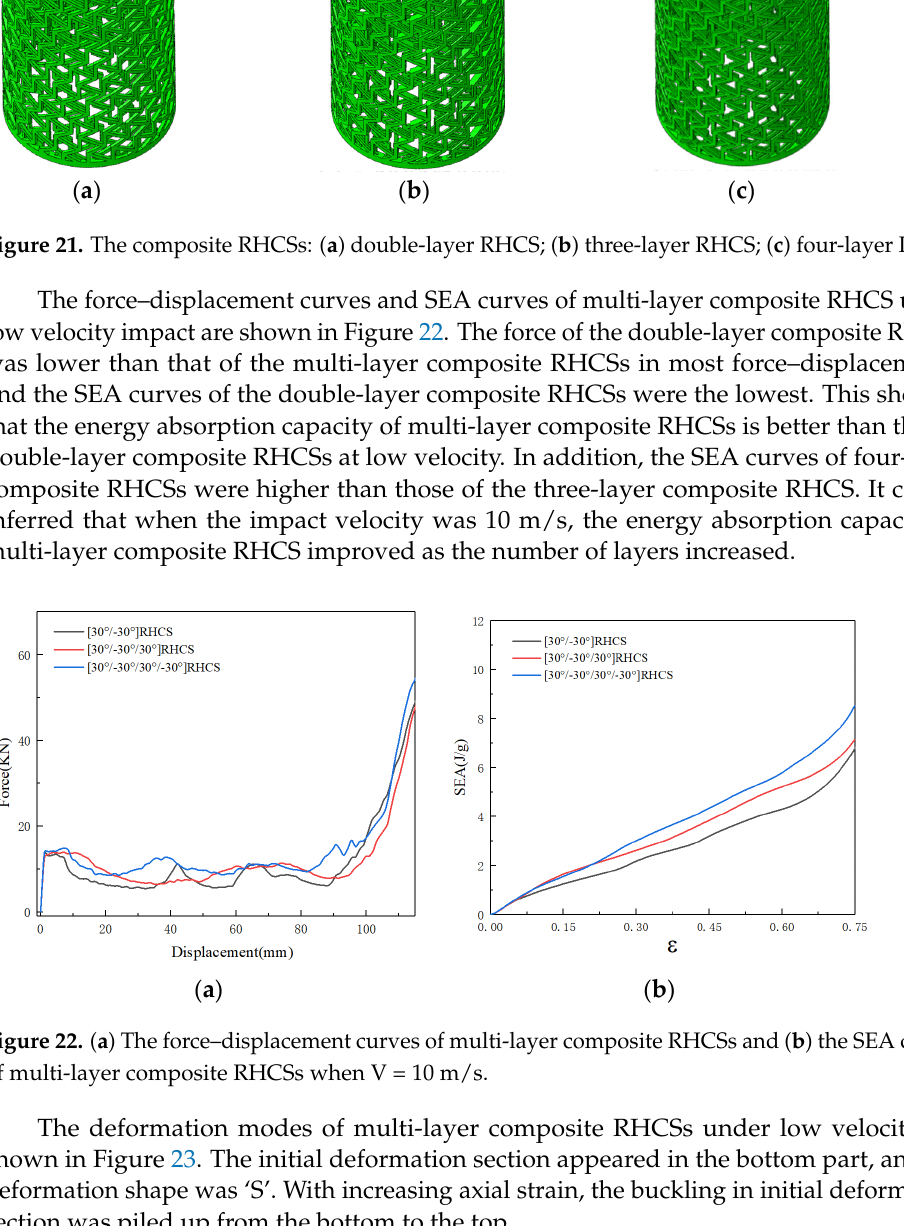
Figure 22. ( a ) The force–displacement curves of multi-layer composite RHCSs and ( b ) the SEA curves of multi-layer composite RHCSs when V = 10m/s.